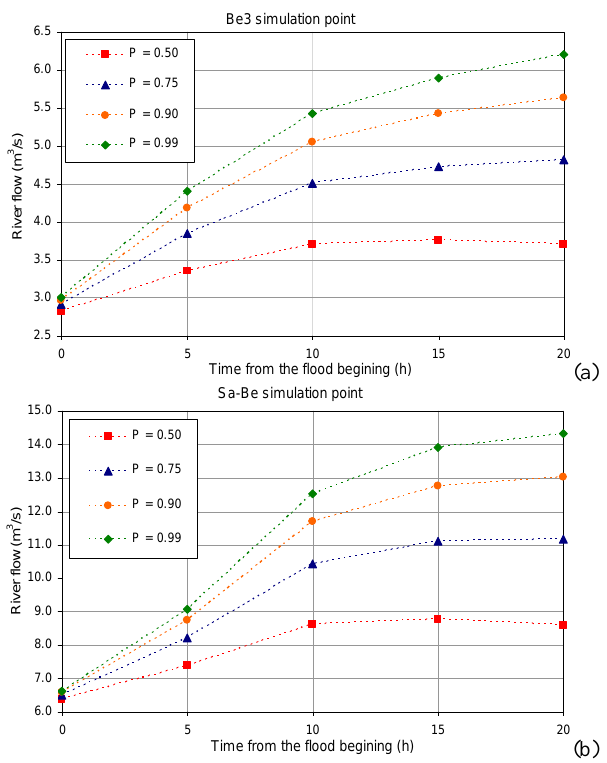
Fig. 8. Temporal evolution of streamflow for storm events during summer period. Each curve is related to a storm non-exceedance probability value. Simulation points are Be3 (a) and Sa-Be (b) .